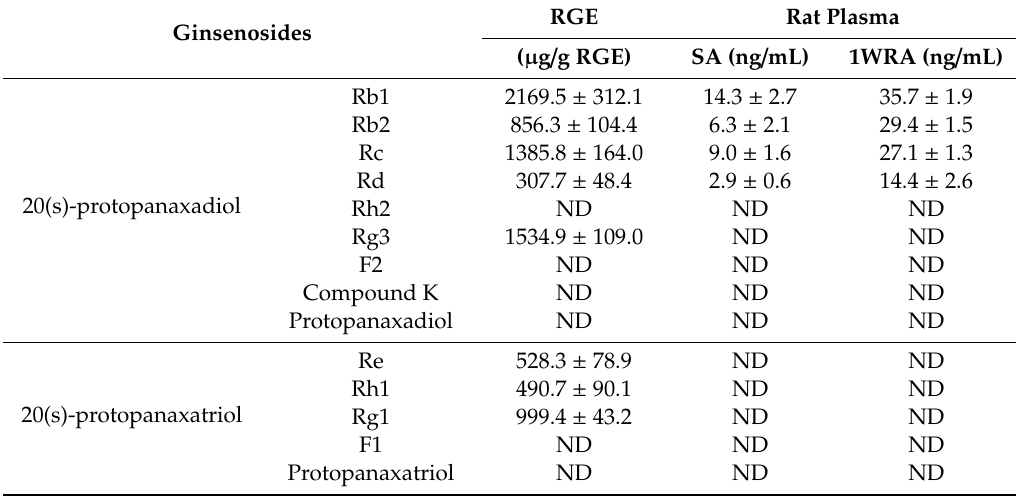
Table 1. Concentrations of ginsenosides in red ginseng extract (RGE) and rat